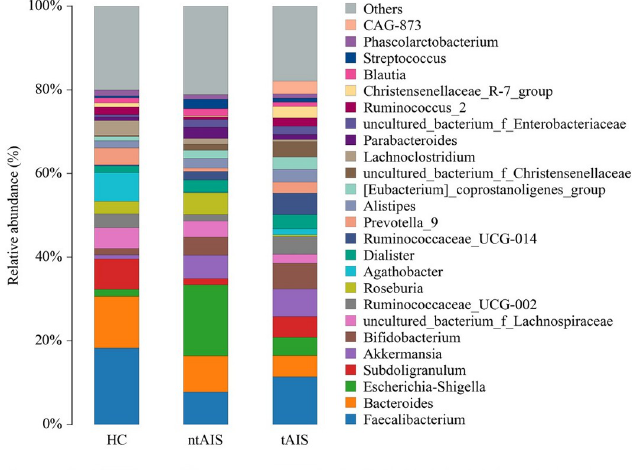
Fig 6. The relative taxa abundance among the three groups at the genus level. AIS: Acute ischemic stroke; tAIS: Patients with PHS; ntAIS: Patients with non-PHS; HC: Healthy controls. The relative species abundances were calculated as percentages of the total species abundances(the number of tags measured in the sample divided by the total number of tags).